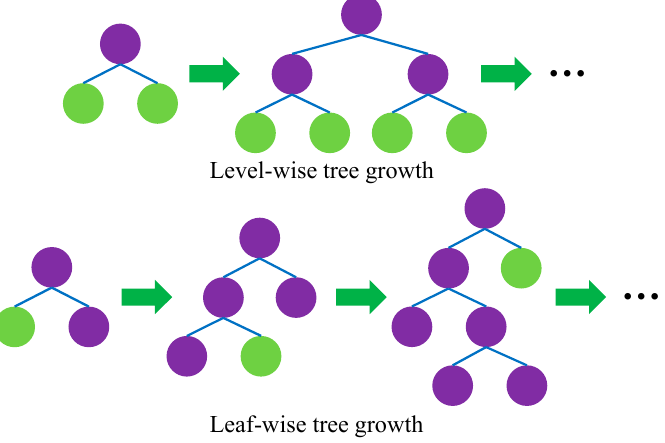
Figure 5. Level-wise and leaf-wise tree construction.